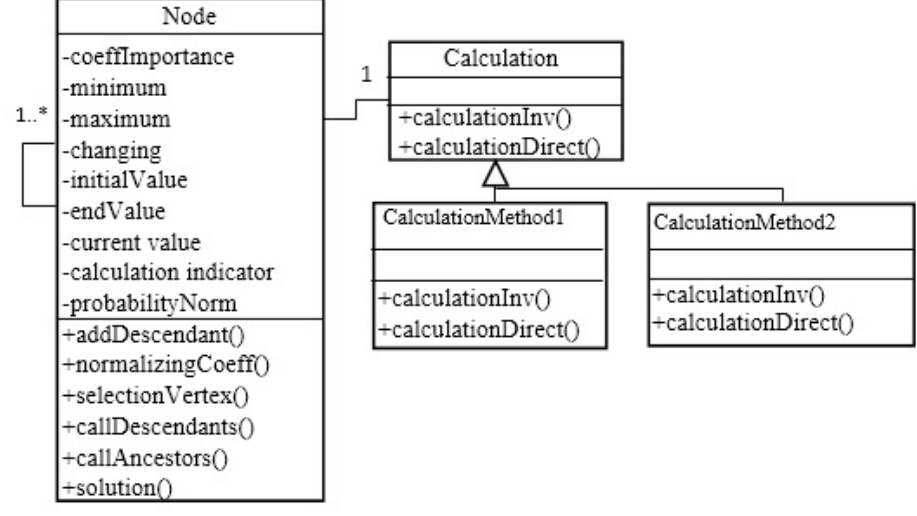
Figure 10. Structure of